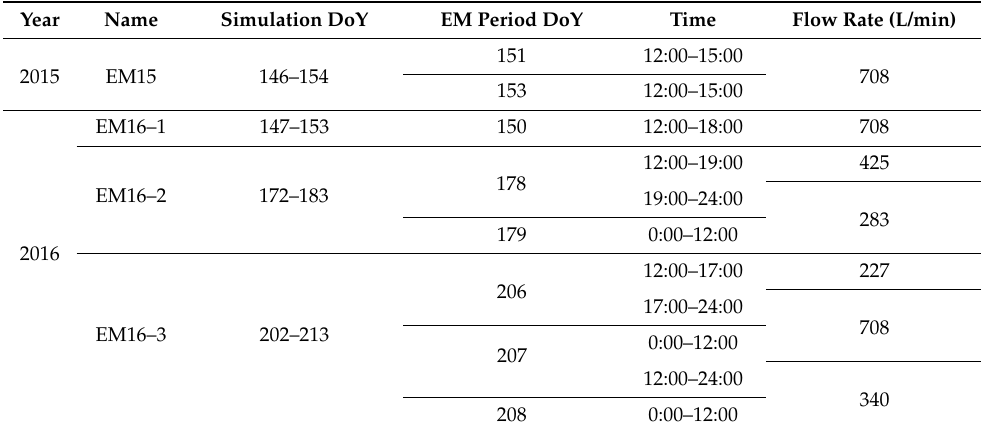
Table 2. The Si3D-AED2 and GLM-AED2 simulation dates, the EM operation periods and the corresponding flow rates in the years 2015 and